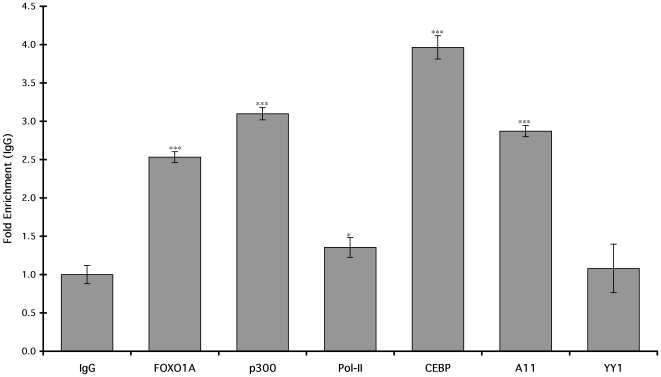
Chromatin immunoprecipitation assay for transcription factors at the dPRL enhancer.Chromatin immunoprecipiation was performed in differentiated hESC with either a control IgG, or antibodies to FOXO1A, p300, Pol-II, C/EBPβ, HoxA-11 or YY1. Results are shown as fold enrichment over IgG (after normalization to inputs). n = 6 replicate experiments, means±SEM. *, P<0.05; ***, P<0.001 (t-test compared to IgG).